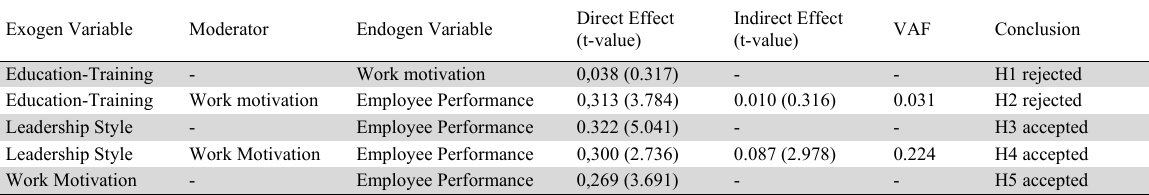
PLS Results of the Structural